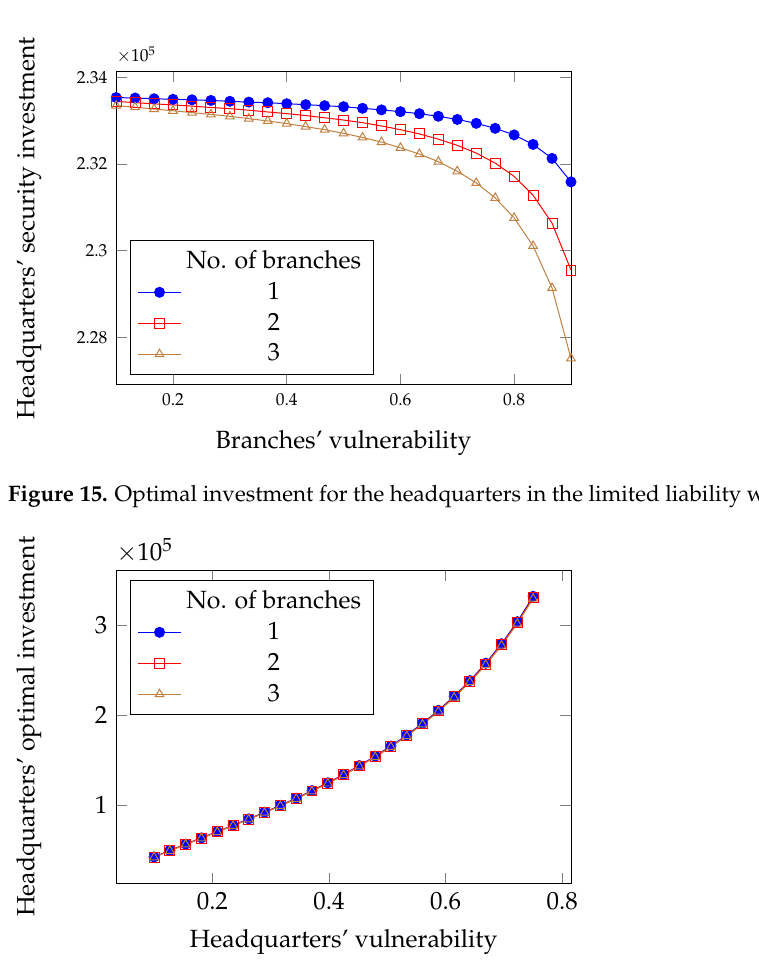
Figure 16. Impact of the intrinsic vulnerability on the optimal investment in the limited liability with deductibles case.